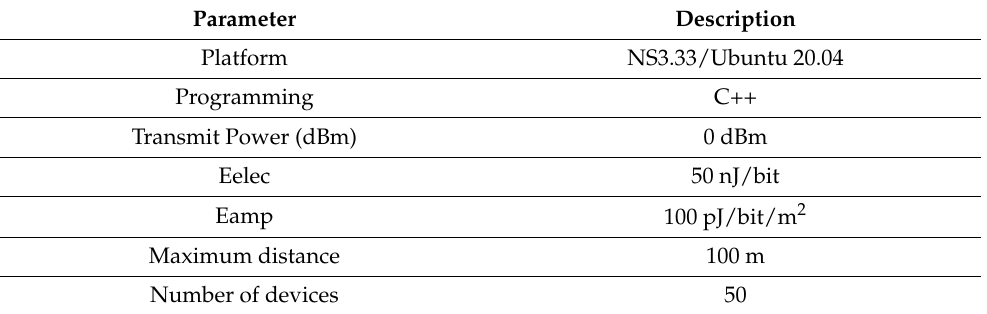
Table 5. Simulation